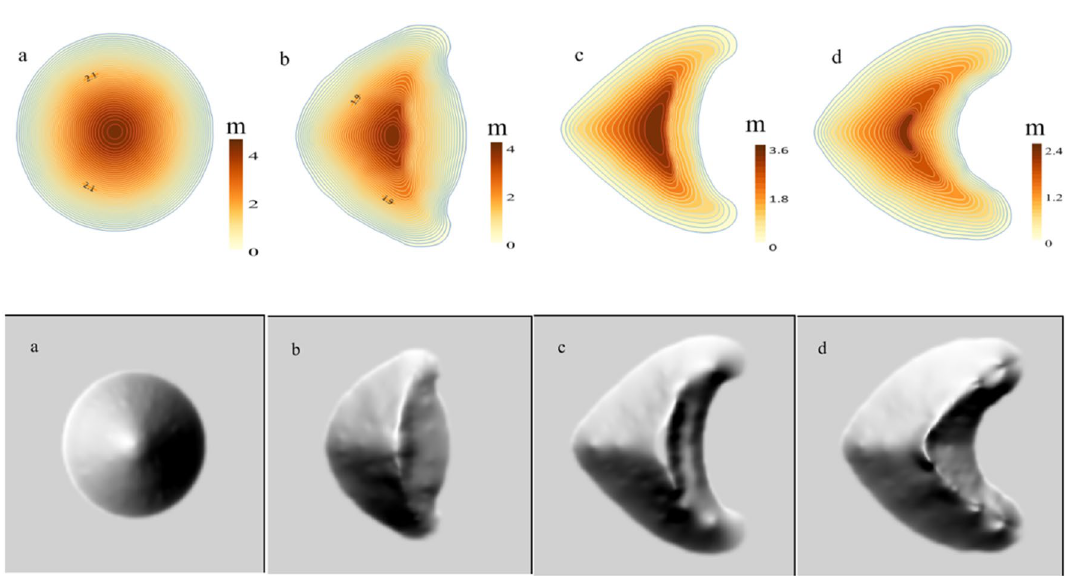
Figure 7. Morphological evolutions of sand dunes at different stages. The map was plotted using Surfer 16 (https ://www.golde nsoft